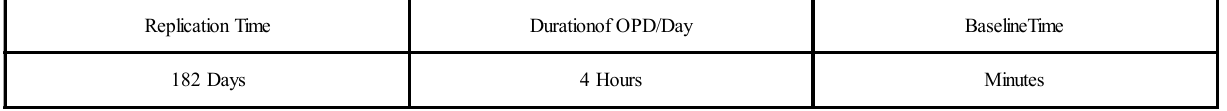
TABLE 2. REPLICATION PARAMETERS SET FOR THE SIMULATION OF MODEL